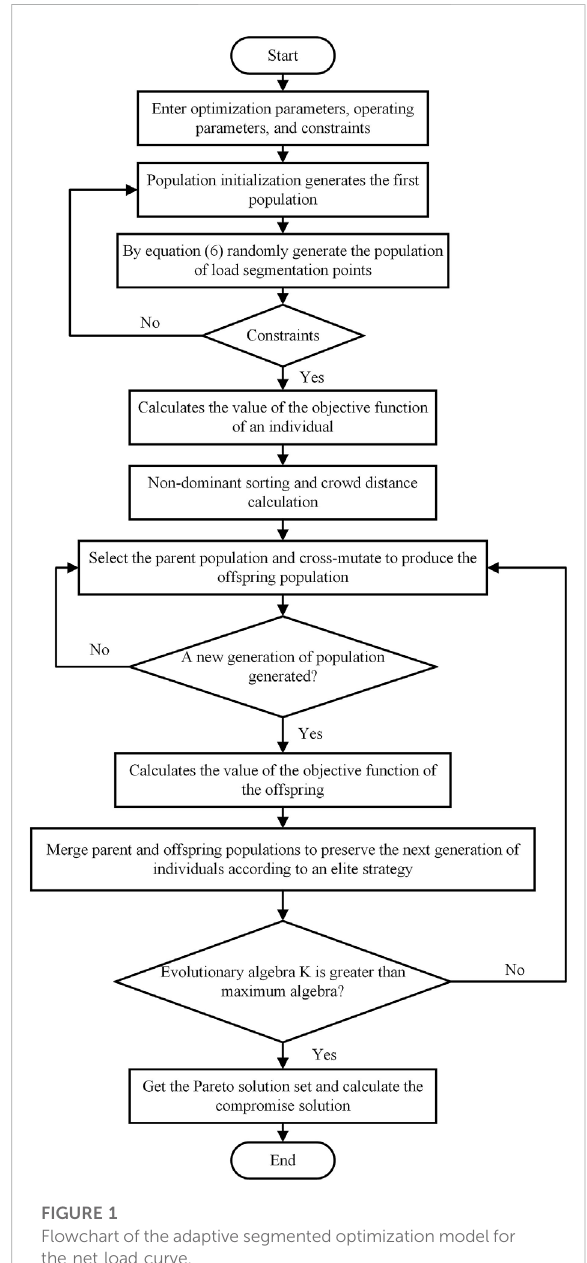
FIGURE 1 Flowchart of the adaptive segmented optimization model for the net load